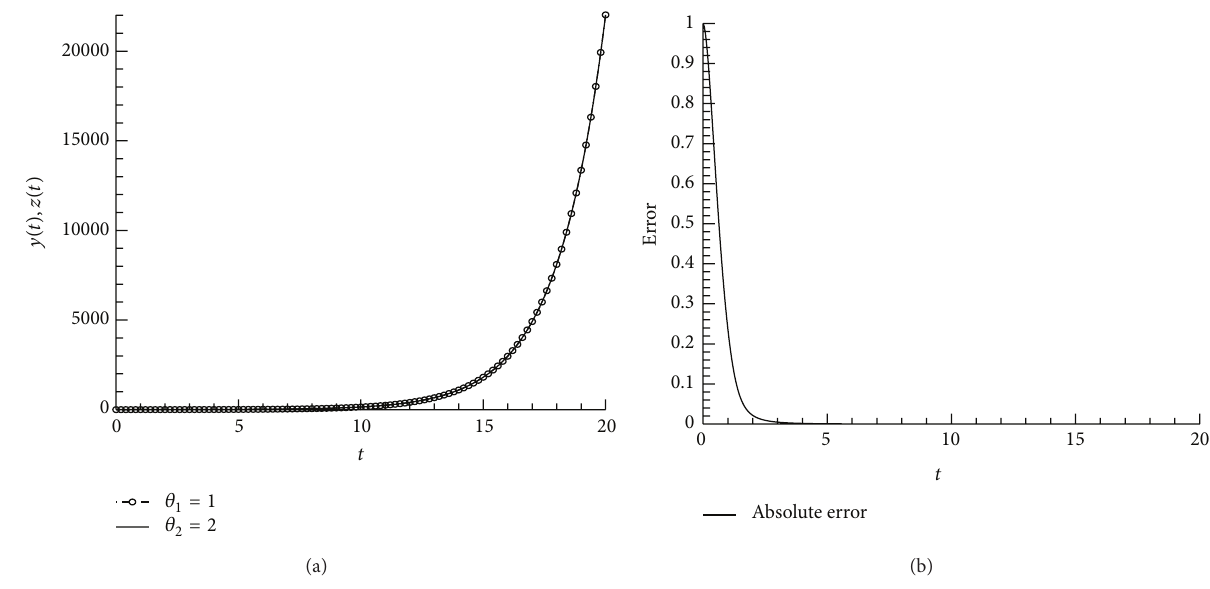
Figure 8: The numerical results of the problems (110) and (111); ℎ = 0.5 , 𝛼 = 0.8, 𝜃 1 = 1.0, 𝜃 2 = 2.0, 𝜙 1 = 0.9, 𝜙 2 = 0.98 .